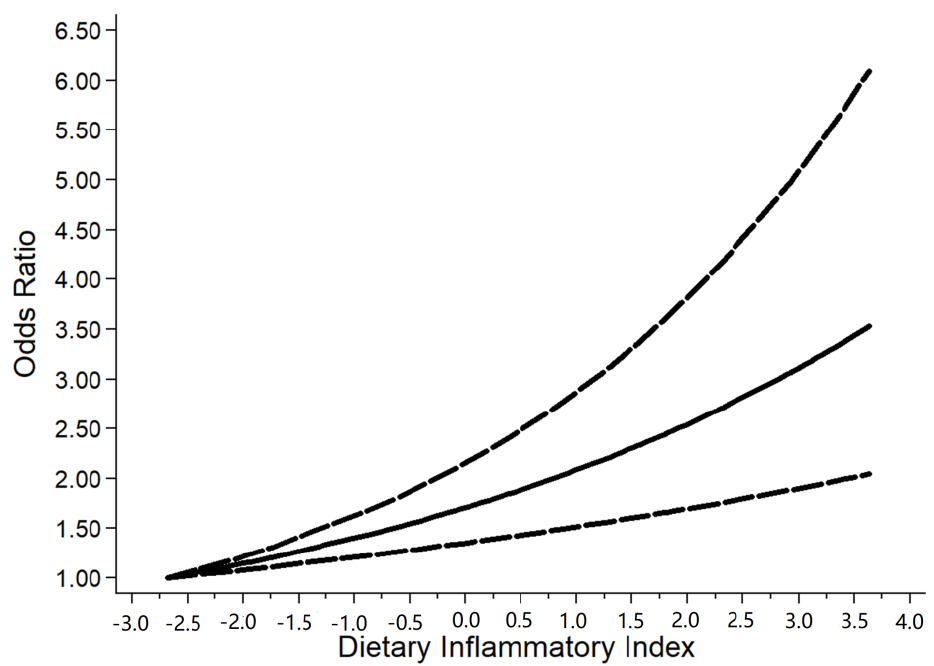
Figure 7. Dose–response plot of the DII and Figure 7. Dose – response plot of the DII and sarcopenia.